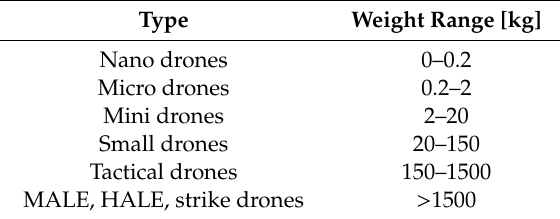
Table 2. Classification of UAVs following the weight methodology of Brooke-Holland [68].